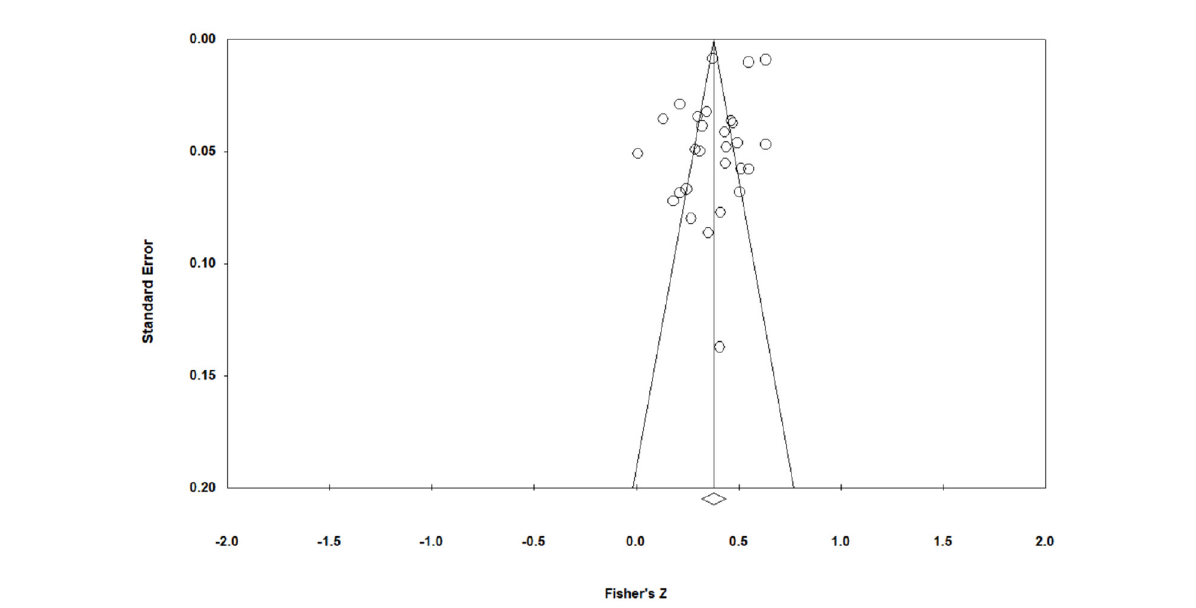
FIGURE3 Funnel plot of the distribution of each effect value (the effect values of public service motivation and work engagement are mainly concentrated at the top of the funnel plot and spread more evenly on both sides of the midline 0.359).